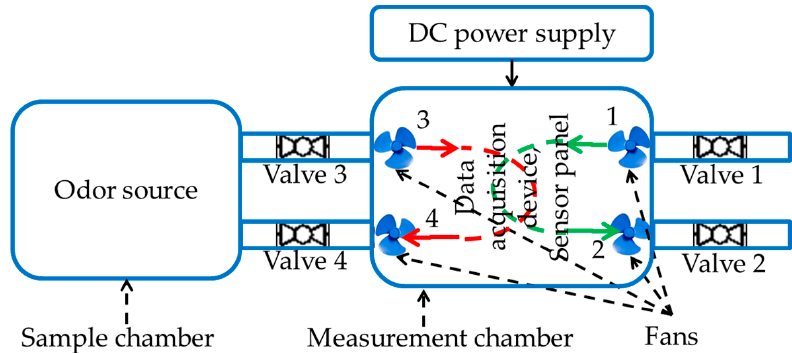
Figure 4. The E-Nose experimental setup. Valves 1 and 2, and Fans 1 and 2 are for air flow control, Valves 3 and 4, and Fans 3 and 4 are for circulating the odor between sample chamber and measurement chamber. A DC power supply powers the sensors, fans, and the data acquisition device. In the figure DC stands for direct current.